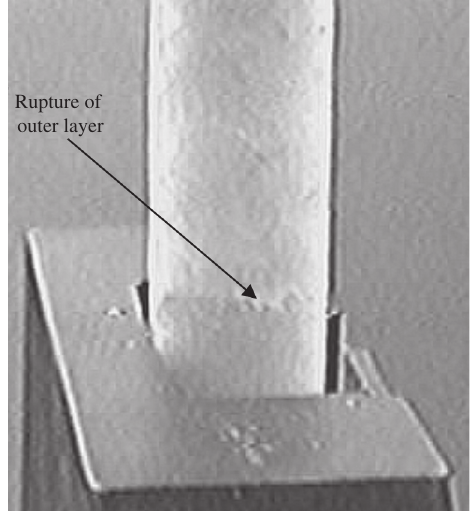
Figure 3. Damage Formation and Propagation Diagrams (DFPD) for laminate: a) C10; b) C12 with R =